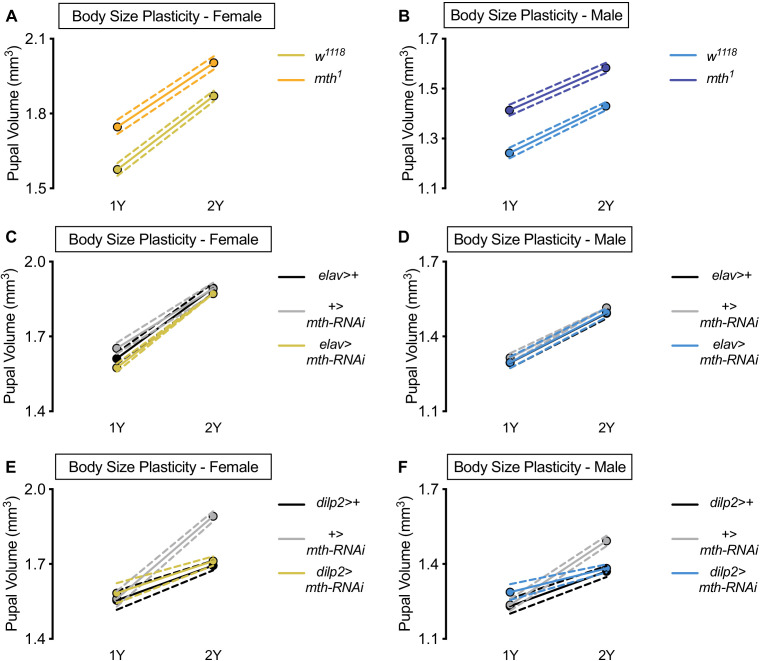
methuselah (mth) is dispensable for nutrient-dependent increased female body size plasticity.(A) Pupal volume was significantly higher in w1118 females and mth1 mutant females reared on a protein-rich diet (2Y) compared with genotype-matched females cultured on a diet with half the protein (1Y) (p<0.0001 for both genotypes; two-way ANOVA followed by Tukey HSD test). The magnitude of the nutrient-dependent increase in pupal volume was not significantly different between the genotypes (genotype:diet interaction p=0.1383; two-way ANOVA followed by Tukey HSD test). n = 59–69 pupae. (B) Pupal volume was significantly higher in w1118 males and mth1 mutant males reared on 2Y compared with genotype-matched males cultured on 1Y (p<0.0001 for both genotypes; two-way ANOVA followed by Tukey HSD test). The magnitude of the nutrient-dependent increase in pupal volume was not significantly different between genotypes (genotype:diet interaction p=0.3697; two-way ANOVA followed by Tukey HSD test). n = 60–75 pupae. (C) Pupal volume was significantly higher in elav>+, +>UAS-mth-RNAi, and elav>UAS-mth-RNAi females reared on 2Y compared with genotype-matched females cultured on 1Y (p<0.0001 for all genotypes; two-way ANOVA followed by Tukey HSD test). The magnitude of the nutrient-dependent increase in pupal volume was not significantly larger in elav>UAS-mth-RNAi females, but was significantly different in +>UAS-mth-RNAi females (genotype:diet interaction p=0.0148; two-way ANOVA followed by Tukey HSD test). n = 53–77 pupae. (D) Pupal volume was significantly higher in elav>+, +>UAS-mth-RNAi, and elav>UAS-mth-RNAi males reared on 2Y compared with genotype-matched males cultured on 1Y (p<0.0001 for all genotypes; two-way ANOVA followed by Tukey HSD test). The magnitude of the nutrient-dependent increase in pupal volume was not significantly different (genotype:diet interaction p=0.9947; two-way ANOVA followed by Tukey HSD test). n = 57–86 pupae. (E) Pupal volume was significantly higher in dilp2>+, +>UAS-mth-RNAi, and dilp2>UAS-mth-RNAi females reared on 2Y compared with genotype-matched females cultured on 1Y (p<0.0001 for all genotypes; two-way ANOVA followed by Tukey HSD test). The magnitude of the nutrient-dependent increase in pupal volume was significantly blunted in both dilp2>+ and dilp2>UAS-mth-RNAi females (genotype:diet interaction p<0.0001; two-way ANOVA followed by Tukey HSD test). n = 36–64 pupae. (F) Pupal volume was significantly higher in dilp2>+, +>UAS-mth-RNAi, and dilp2>UAS-mth-RNAi males reared on 2Y compared with genotype-matched males cultured on 1Y (p<0.0001 for all genotypes; two-way ANOVA followed by Tukey HSD test). The magnitude of the nutrient-dependent increase in pupal volume was significantly blunted in dilp2>+ and dilp2>UAS-mth-RNAi males (genotype:diet interaction p<0.0001; two-way ANOVA followed by Tukey HSD test). n = 34–63 pupae. For body size plasticity graphs, filled circles indicate mean pupal volume, and dashed lines indicate 95% confidence interval.